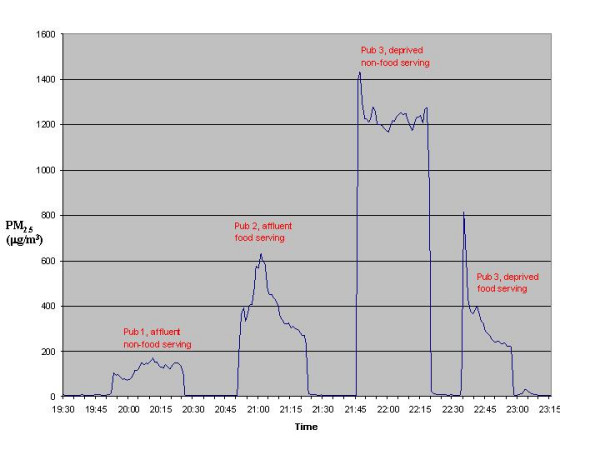
Fine particle levels by pub category on one night's monitoring, September 2005.